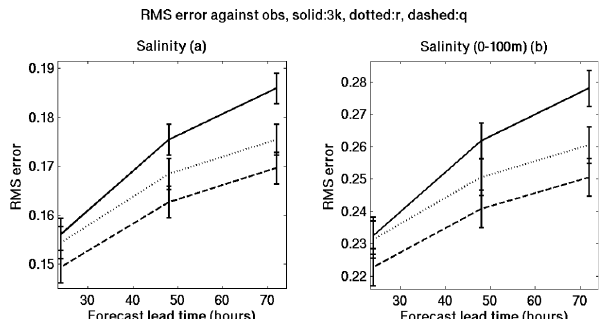
Fig. 7. The RMS errors of salinity for ensembles r (dotted), q (dashed), and ncom3km (solid) as functions of lead time. All the RMS values are averaged over the 109 days from 1 June to 17 September 2012, and averaged over the full observation space (a) , and the layer between 0 and 100m (b) . Error bars based on the standard error indicate the confidence interval.